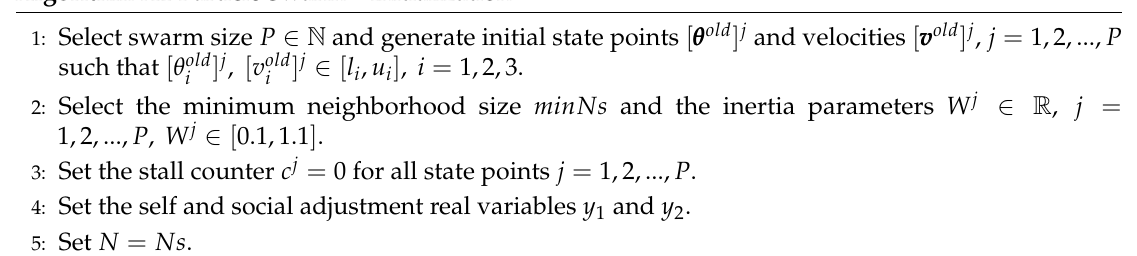
Algorithm A1 Particle